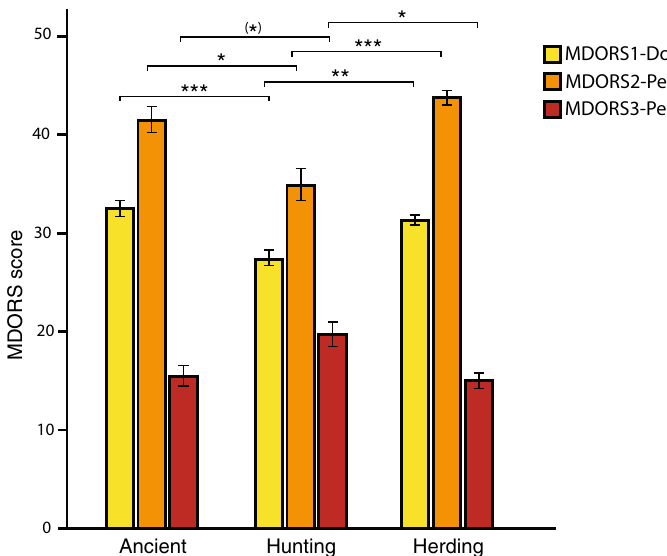
Figure 3. Mean MDORS scores ± SE for the ancient breeds, solitary hunting breeds and herding breeds. Significant differences are indicated by (*)p < 0.06, *p < 0.05, **p < 0.01, ***p < 0.001. This image was created using Adobe Illustrator 2021, version 25.2.1, https:// www. adobe. com.